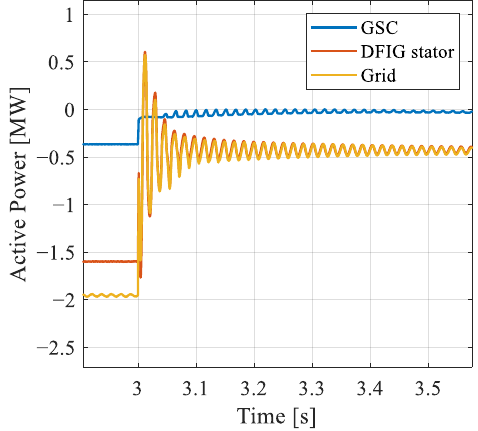
Figure 7. Active powers during a balanced voltage sag.